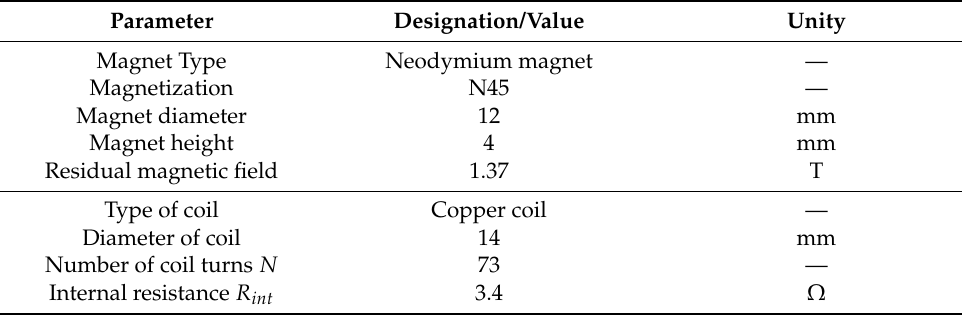
Table 1. Characteristics of the used coils and